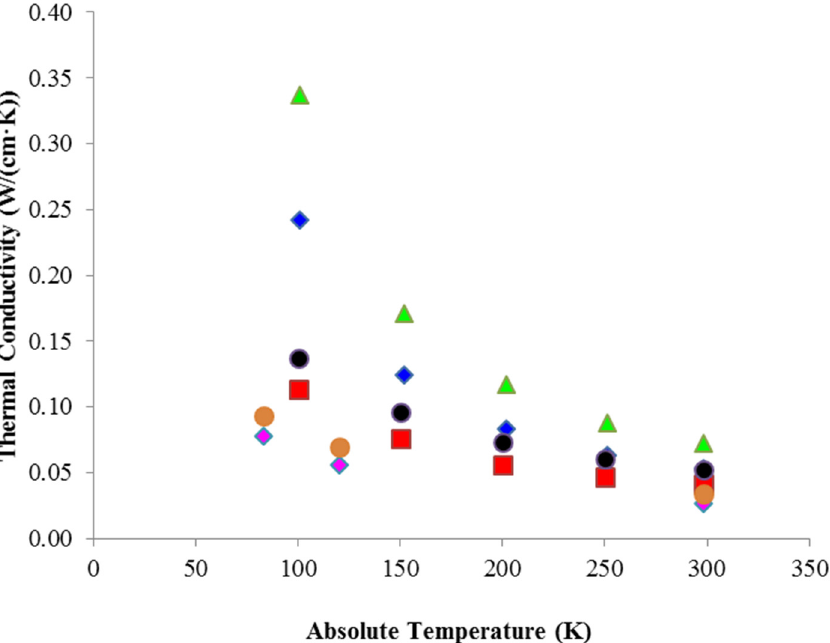
Figure 13. Thermal conductivity as a function of absolute temperature of the uniaxial laser material YLF for undoped, a (blue) and c axes (green), 5 at. % doped, a (red) and c (black) axes, and 25 at. % doped a (pink) and c axes (orange) [29,30].